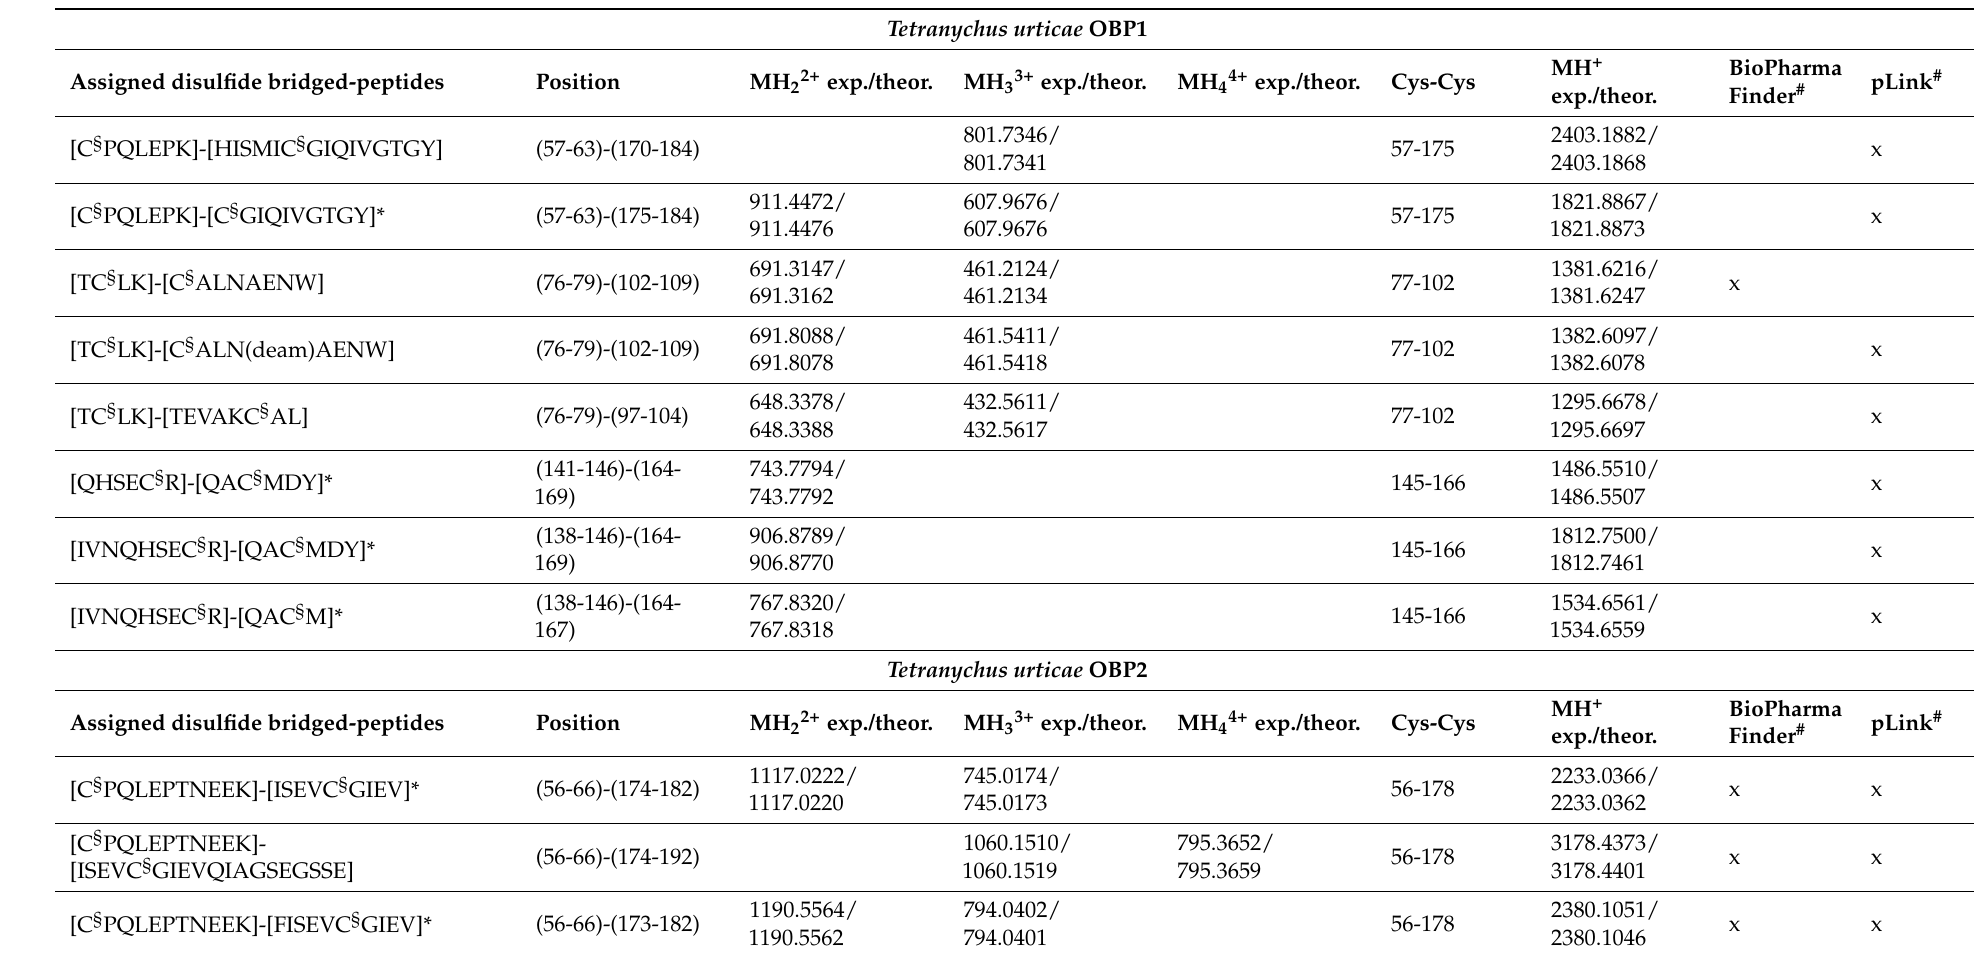
Table 1. Assigned disulfide bridged-peptides identified in the tryptic/chymotryptic digest of Tetranychus urticae OBPs . Reported are the protein under investigation, amino acid sequence, amino acid position within corresponding protein sequence, experimental/theoretical mass value of the observed parent ion, modified cysteine residue, and software used for characterization. § Cysteine involved in disulfide bridge; * bridged peptide with aspecific cut; # software used for